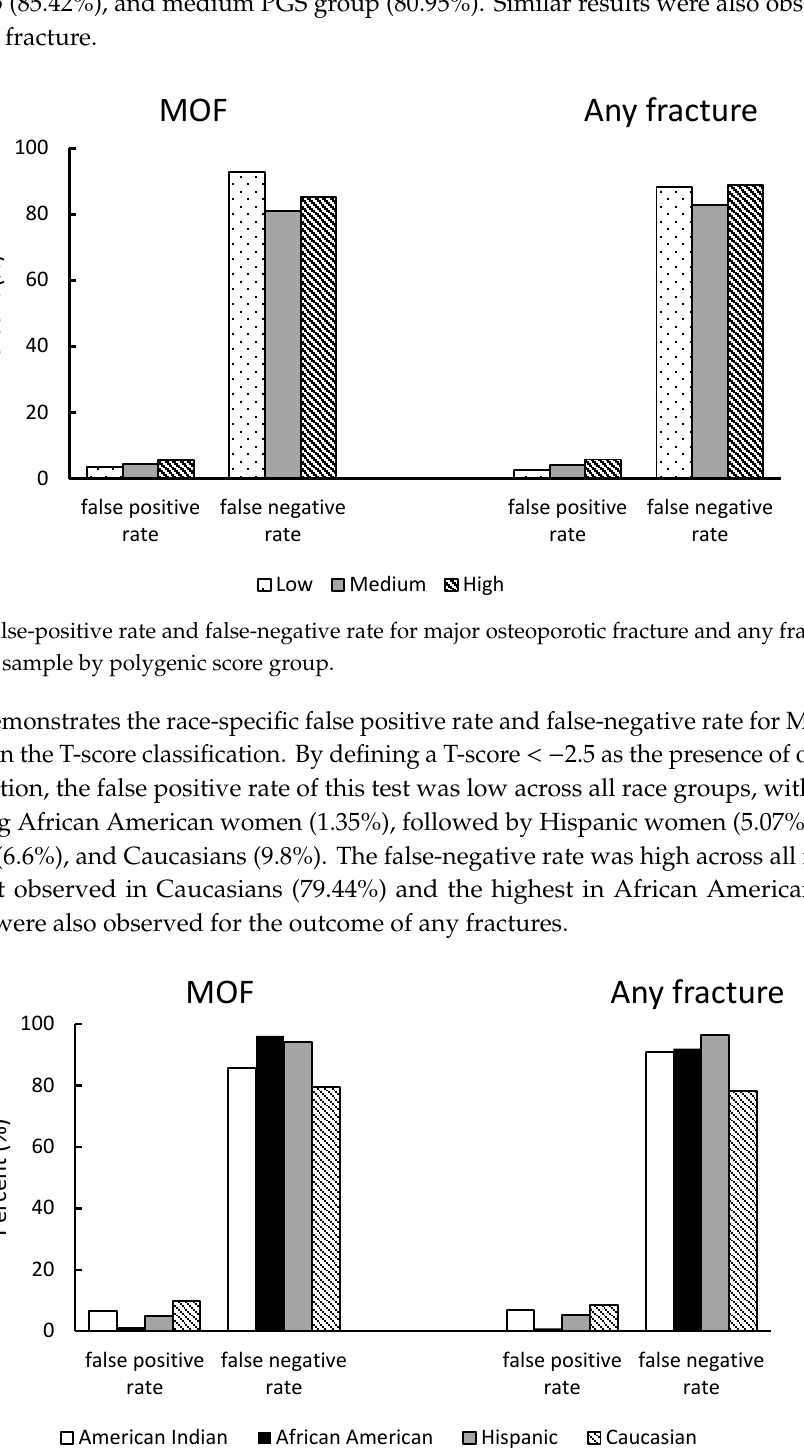
Figure 4. False-positive rate and false-negative rate for major osteoporotic fracture and any fracture in the analytic sample by race.